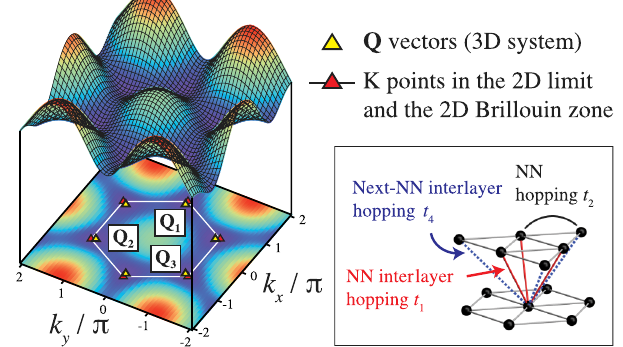
FIG. 1 Single-boson dispersion ω k characterized by six-fold degenerate minima at low-symmetry positions (cid:1) Q 1 ≤ n ≤ 3 (shown for k z ¼ 0 ), which can be realized in the lattice shown in the inset yielding Q 1 ¼ ð 2 α ; α ; α Þ , Q 2 ¼ ð − α ; α ; 0 Þ , and Q 3 ¼ ð − α ; − 2 α ; − α Þ . In Ba 3 Mn 2 O 8 , α is slightly smaller than 2 π = 3 [23].